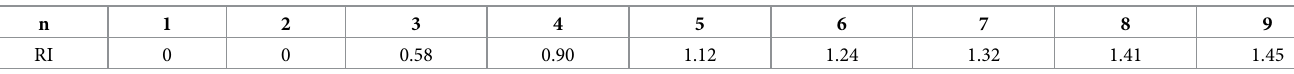
Table 3. The order of the random consistency index with a number of alternatives.